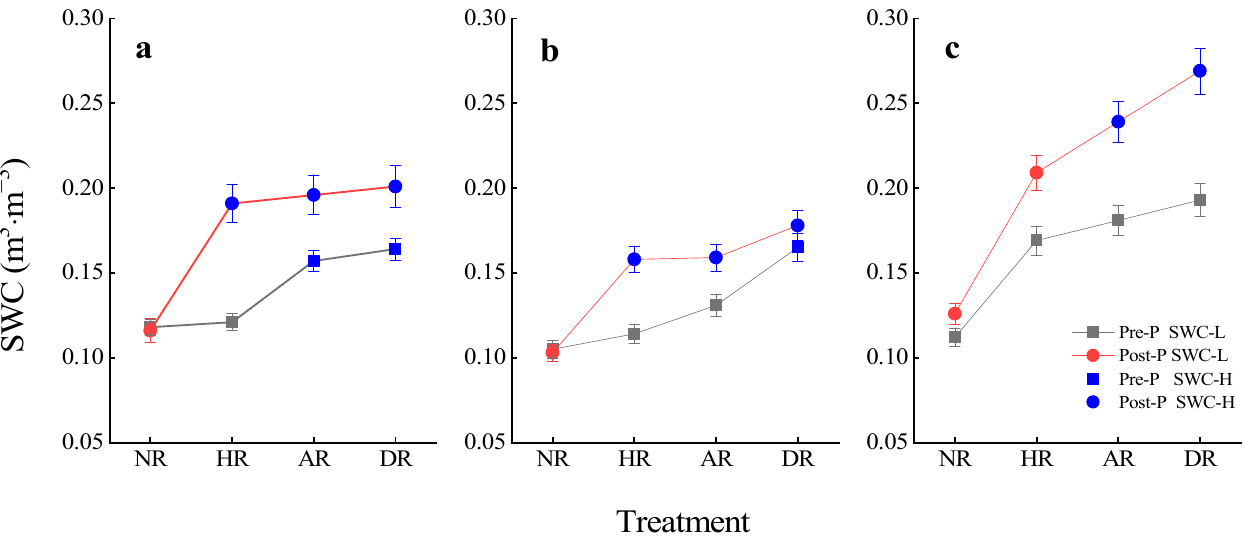
Figure 11. Changes in soil water content before and after three precipitation events. ( a ), Precipitation event on 14 September. ( b ), Precipitation event on 19 August. ( c ), Precipitation event on 19 September.